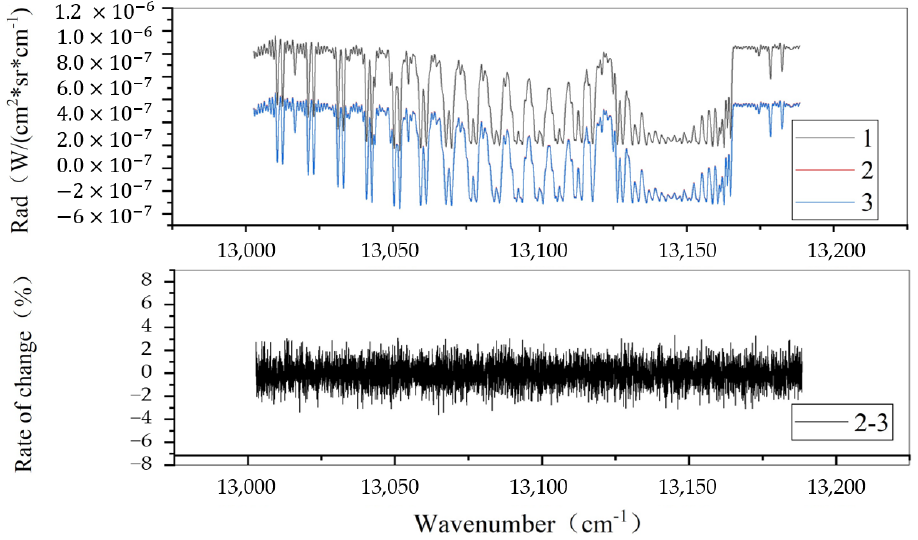
Table 3. Data information of GMI observation points at Kufra, Libya site.